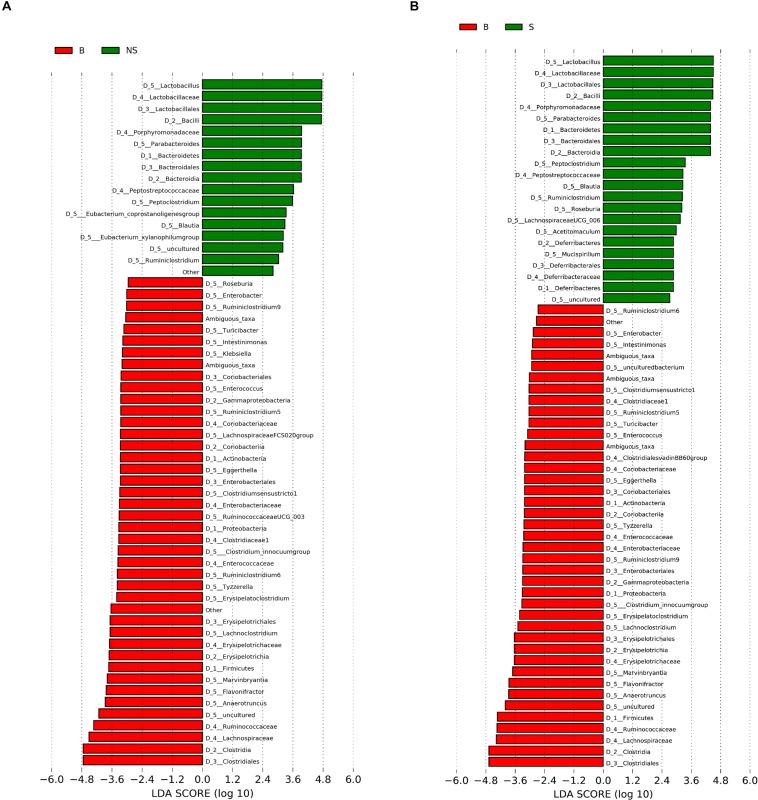
Histogram of the LDA scores for differentially abundant genera between (A) BALB/cA and NOD/SCID mice or (B) BALB/cA and SCID mice. The cladogram was calculated by LEfSe, a metagenome analysis of abundant taxons of OTUs; the cladogram is displayed according to the effect size. Only taxa meeting an LDA significant threshold > 2 and p < 0.05 are shown.